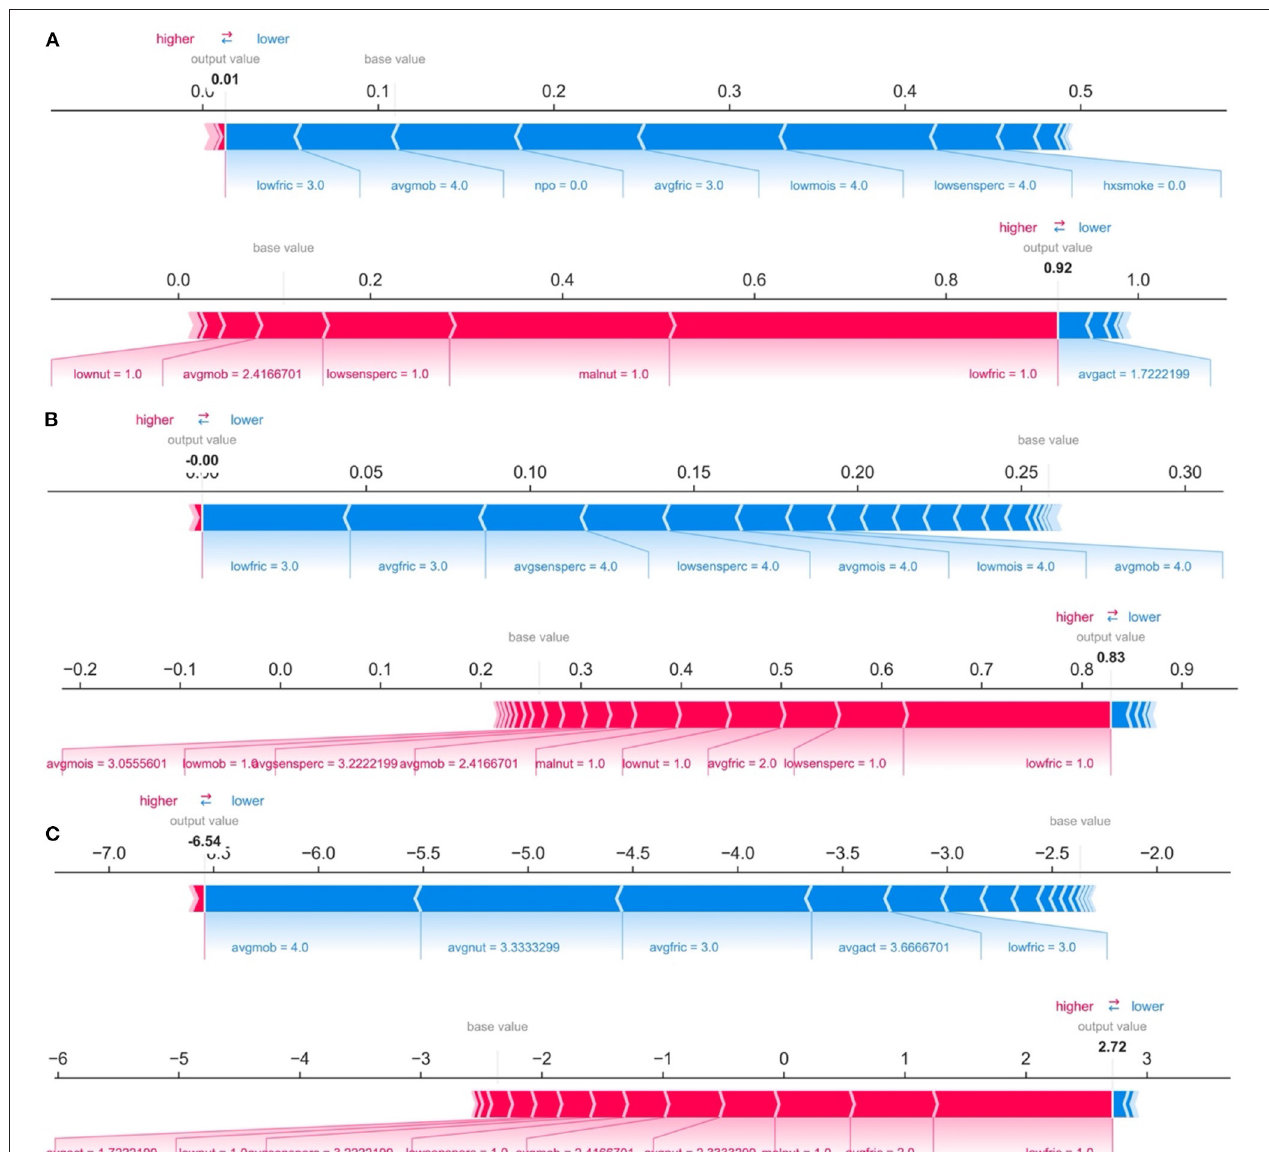
FIGURE 4 | Predictions and decomposition of predictor importance (force plots) for two individuals (top vs. bottom of each panel) using: (A) Logistic Regression, (B) Random Forest, and (C) XGBoost. The predictors are associated with both increased and decreased HAPI. Certain values (e.g., increasing values) may be associated with one or the other. Blue colors indicate predictors that are associated with decreased HAPI incidence, while red colors indicate predictors associated with increased HAPI incidence; magnitude of each arrow indicates the level of importance of the predictor for that